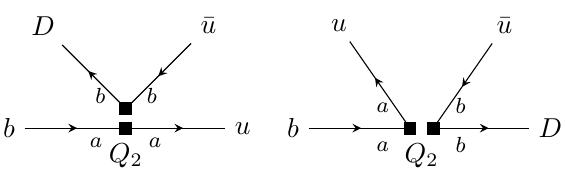
Figure 1 . “Right” and “wrong” insertions of the operator Q 2 ,